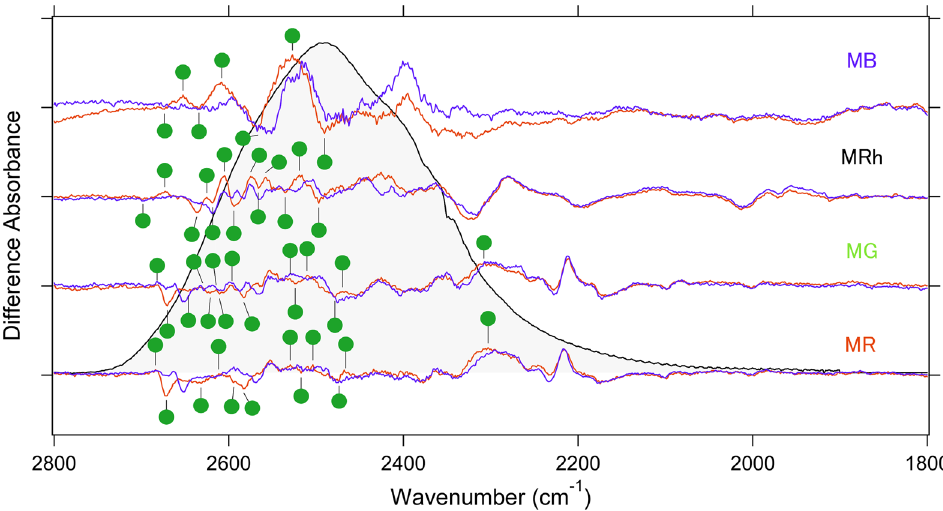
Figure 4. Spectral comparison of the X-D stretching vibrations of MB, MRh, MG and MR in the 28000– 1800 cm − 1 region at 77 K. Red and blue lines represent the spectra in D 2 O and D 218 O, respectively, and green labeled frequencies correspond to those identified as water-stretching vibrations. The gray curve in the 2700– 2000 cm − 1 regions represents O-D stretching vibrations of D 2 O at room temperature. One division of the y-axis corresponds to 0.0002 absorbance